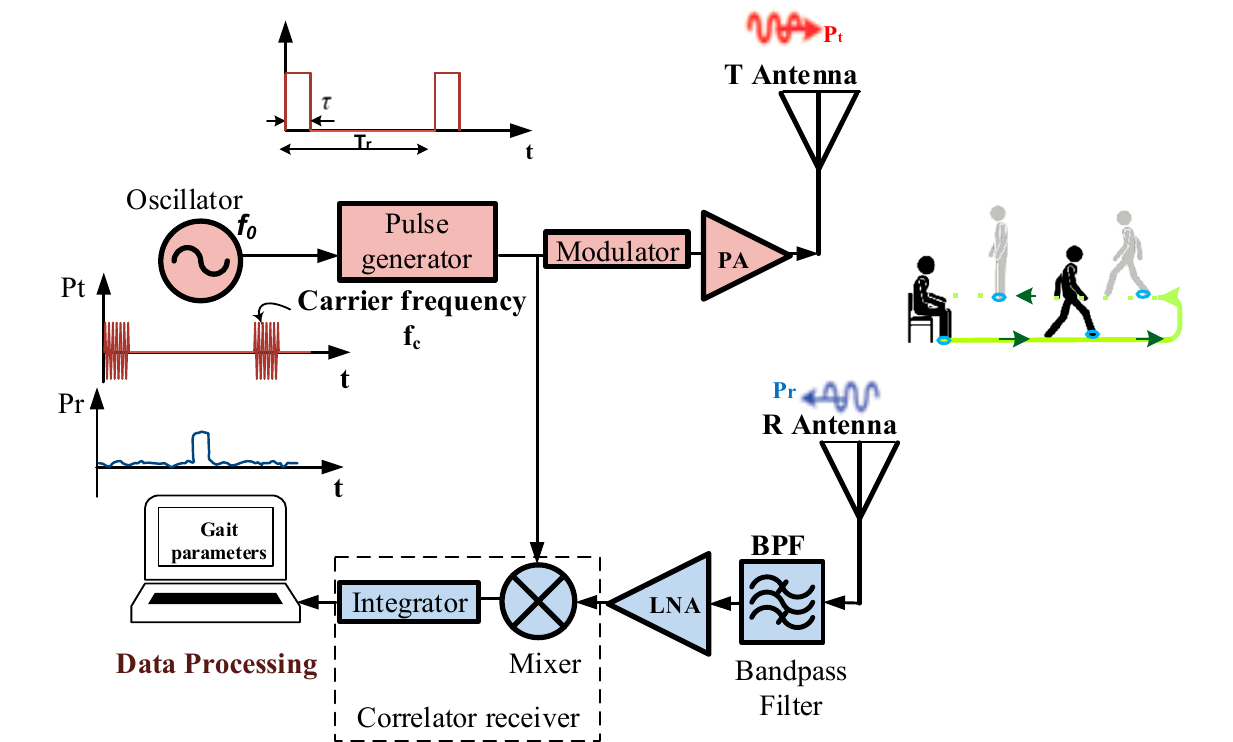
Figure 1. Ultra-wideband (UWB) radar block diagram.